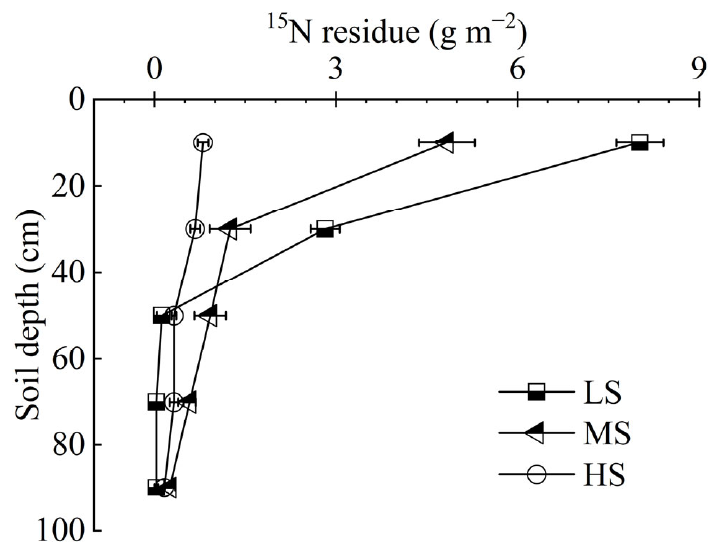
Figure 1. 15 N residues in different depth soil layers of different treatments. The 15 N residues of 0~20 cm soil layer in MS and HS treatments were significantly lower than those in LS treatment by 39.73% and 90.01%, and the 15 N residues of 0~20 cm soil layer in HS treatment were significantly lower than those in MS treatment by